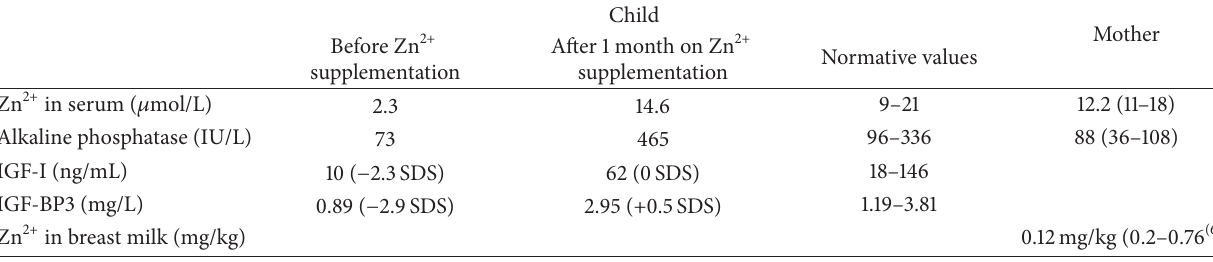
Table 1: Laboratory data of the child (II.3) and mother.